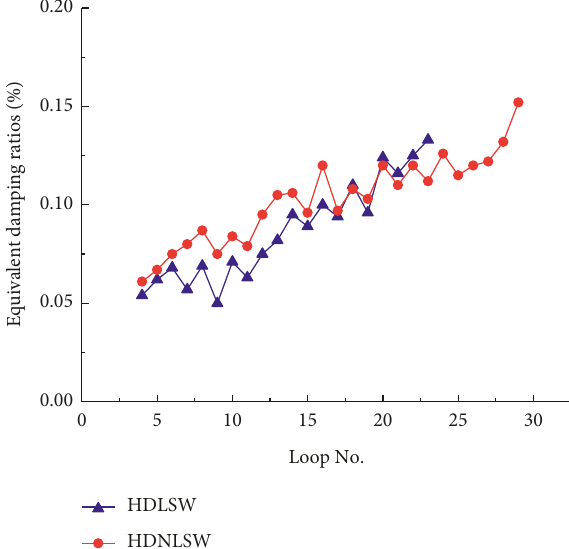
Figure 10: Force-displacement skeleton curves of two specimens.